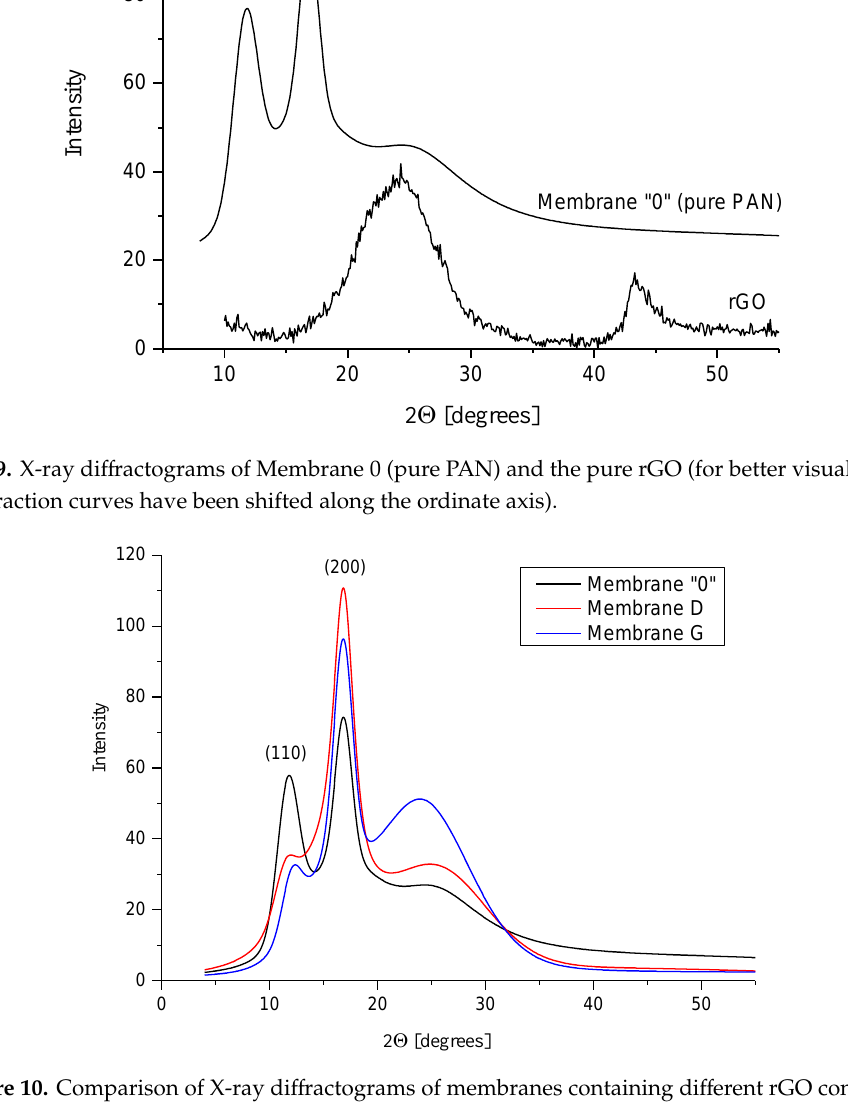
Figure 10. Comparison of X-ray diffractograms of membranes containing different rGO content.